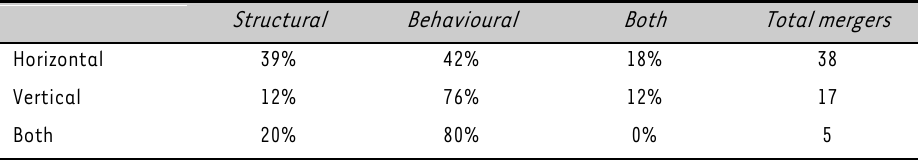
TABLE 2: Merger remedies in horizontal and vertical mergers in South Africa, 2000–2009 Structural Behavioural Both Total